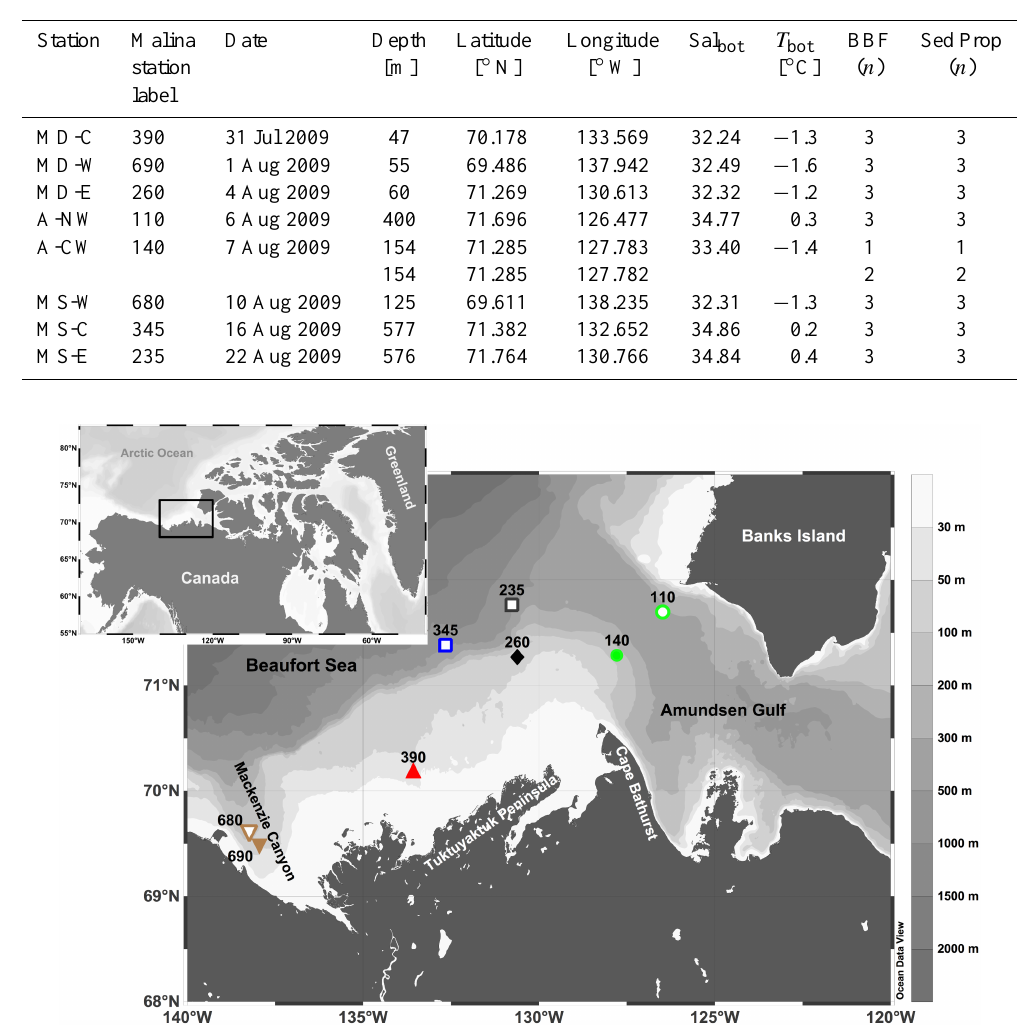
Fig. 1. Locations of sites sampled for benthic boundary fluxes during the Malina expedition in the Beaufort Sea in summer